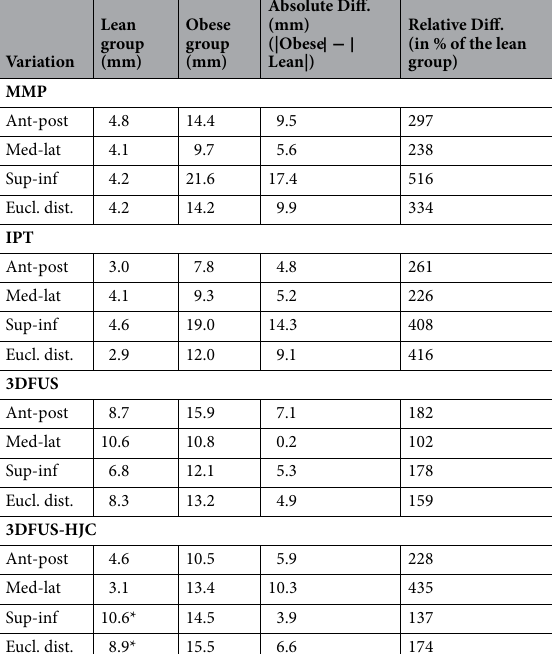
Table 3. Overview of the variation (standard deviation, mm) of the anterior superior iliac spine (ASIS) and hip joint center (HJC) locations between test and retest (first two columns) as well as the absolute difference (mm) and relative difference (in% of the lean group) between both groups. *Note that there are two outliers (from one person) present, which contribute to the high values (see Fig. 2). MMP manual marker placement, IPT instrumented pointer technique 3DFUS 3D free-hand ultrasound, HJC hip joint